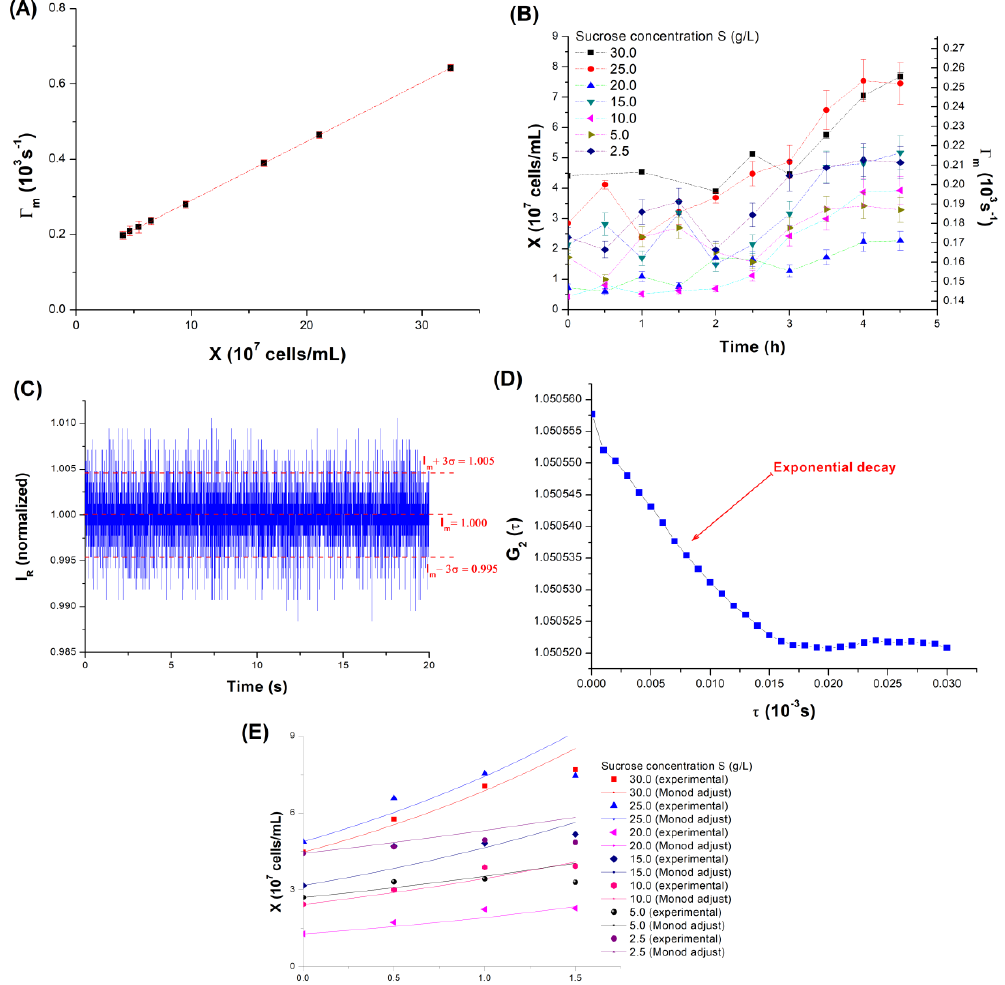
Figure 3. ( A ) Correlation between Γ m and the concentration of cells; ( B ) concentrations experimentally obtained with the microfermentor for each concentration of sucrose in the microchannels, with the Γ m values shown on the secondary axis; ( C ) normalized optical intensity I R corresponding to the highest verified Γ m (30 g / L of sucrose, t = 4.5 h), and its interval I m ± 3 σ ; ( D ) autocorrelation function G 2 ( τ ) obtained from the signal of Figure 3C, showing the decay characteristic of the quasi-elastic light scattering (QELS); ( E ) comparison between experimental results of the microfermentor and the curves obtained with the Monod equation solved for the parameters calculated by the Visual Basic for Applications (VBA) algorithm (K M = 4.1 g/L and μ m = 0.49 h − 1 ).